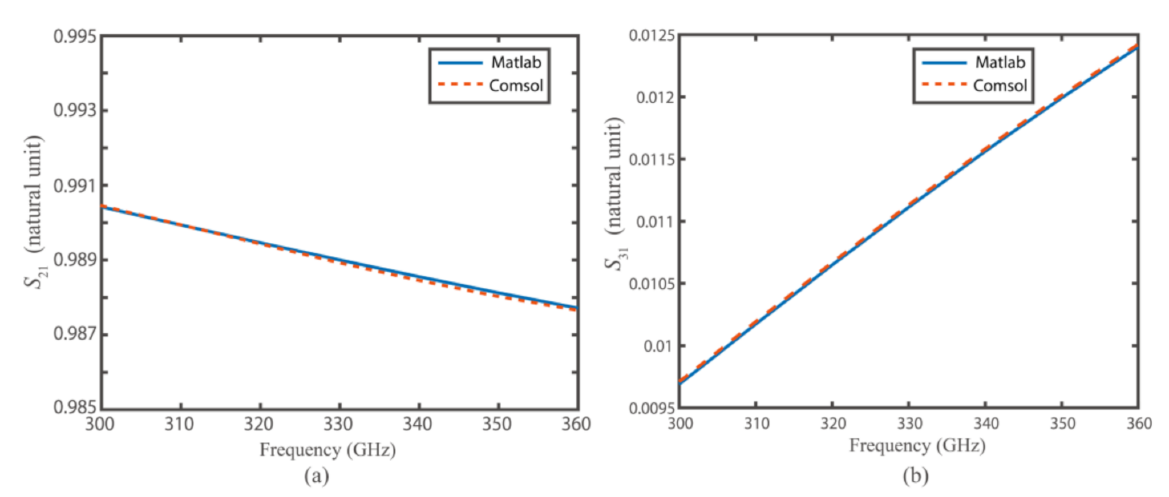
Figure 12. ( a ) Transmission coefficient T ( S 21 ) and ( b ) reflection coefficient R ( S 31 ) when the linear polarization direction of the EM waves is perpendicular to the cylindrical wire array plane in the frequency band ranging from 300 to 360